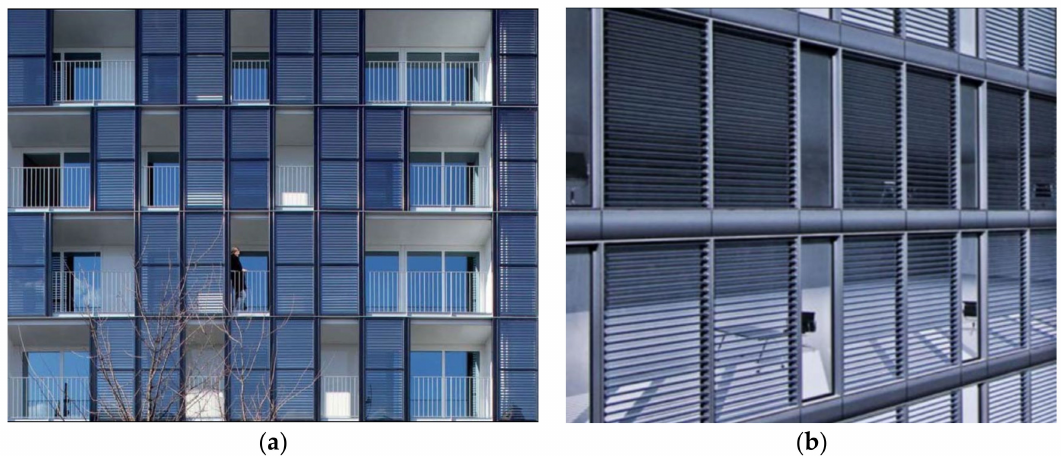
Figure 6. ( a ) Philippon-Kalt Architectes Public House; ( b ) evacuated tube collectors shading